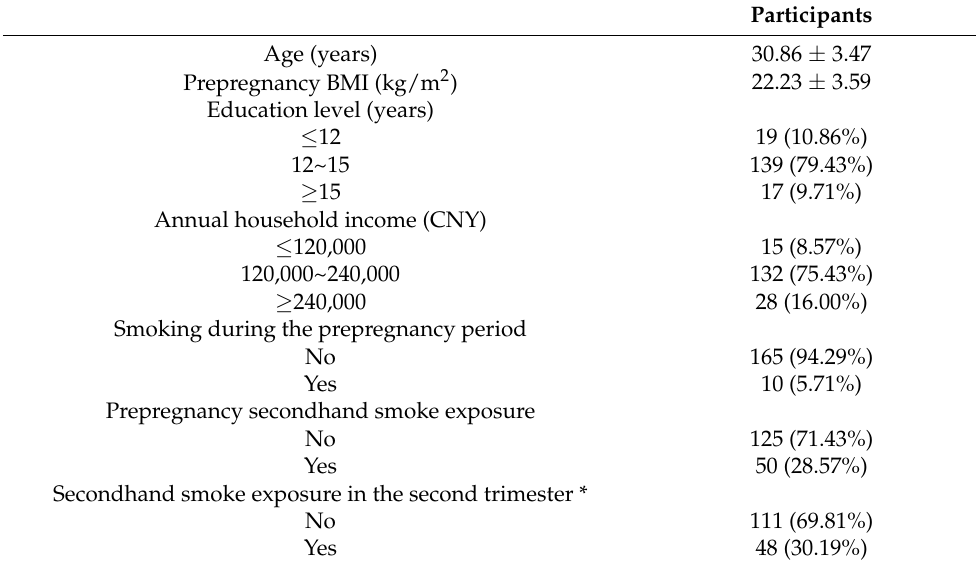
Table 1. Characteristics and DII scores of participants ( n = 175) #